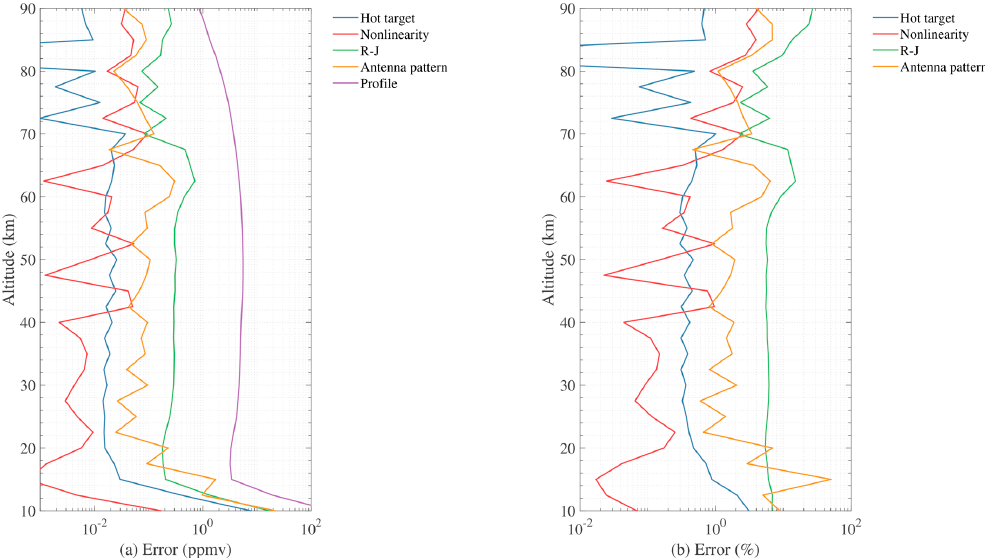
Figure 11. The H 2 O retrieval errors induced by different calibration error sources: ( a ) absolute and ( b ) relative retrieval errors. The uncertainties assumed are summarized in Table 4.